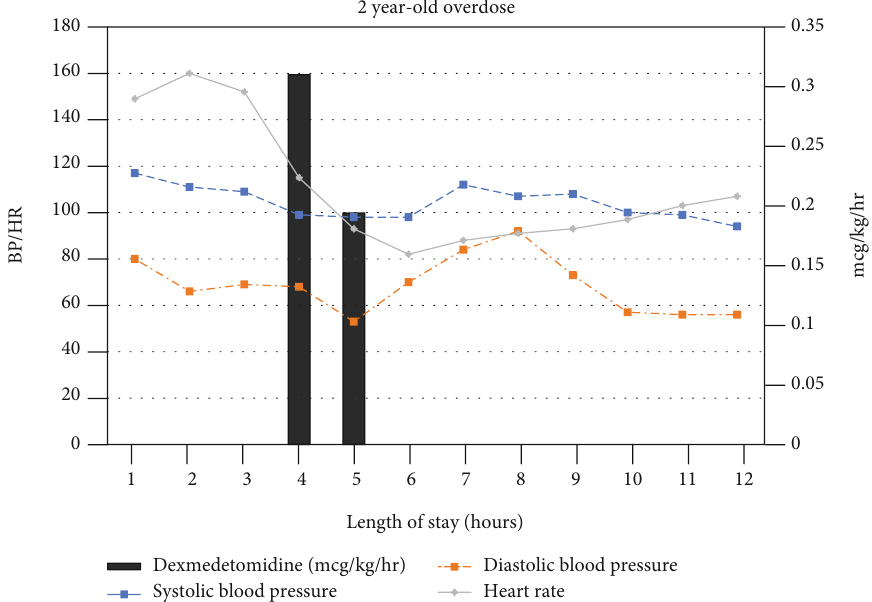
Figure 1: The patient is initially hypertensive and tachycardic. At hour 4, dexmedetomidine was introduced and the patient ’ s vital signs began to